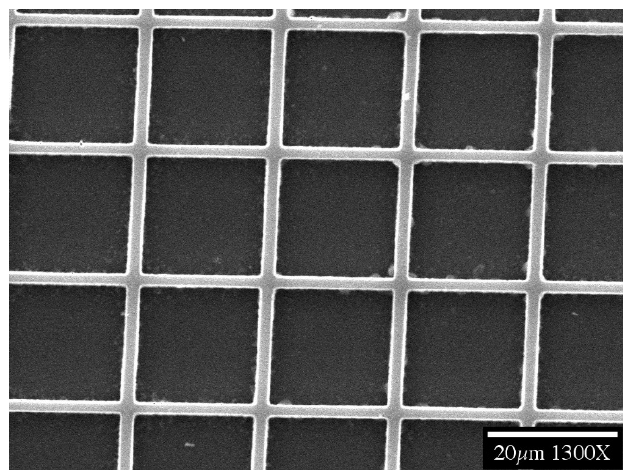
Figure 3. SEM image of the photonic crystal structures fabricated via interference lithography (top view).